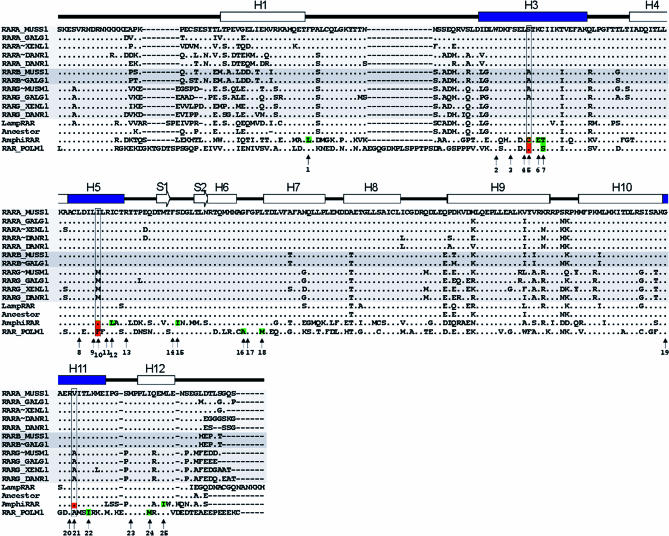
Protein Sequence Alignment of Selected Gnathostome RARsRARs are represented from lamprey (LampRAR, Petromyzon marinus), amphioxus (AmphiRAR, Branchiostoma floridae), tunicate (RAR_POLM1, Polyandrocarpa misakiensis), and the synthetic predicted ancestral RAR (Ancestor). The position of the 12 helices is indicated above the alignment (H1–H12). Residues implicated in direct contacts with the ligand are numbered from 1 to 25 below the alignment. The three divergent residues within the LBP between vertebrate RARs are within vertical rectangles in helices 3, 5, and 11. Gnathostome and Polyandrocarpa sequences are named with the nomenclature code used in the nuclear receptor database NUREBASE (http://www.ens-lyon.fr/LBMC/laudet/nurebase/nurebase.html) [39].